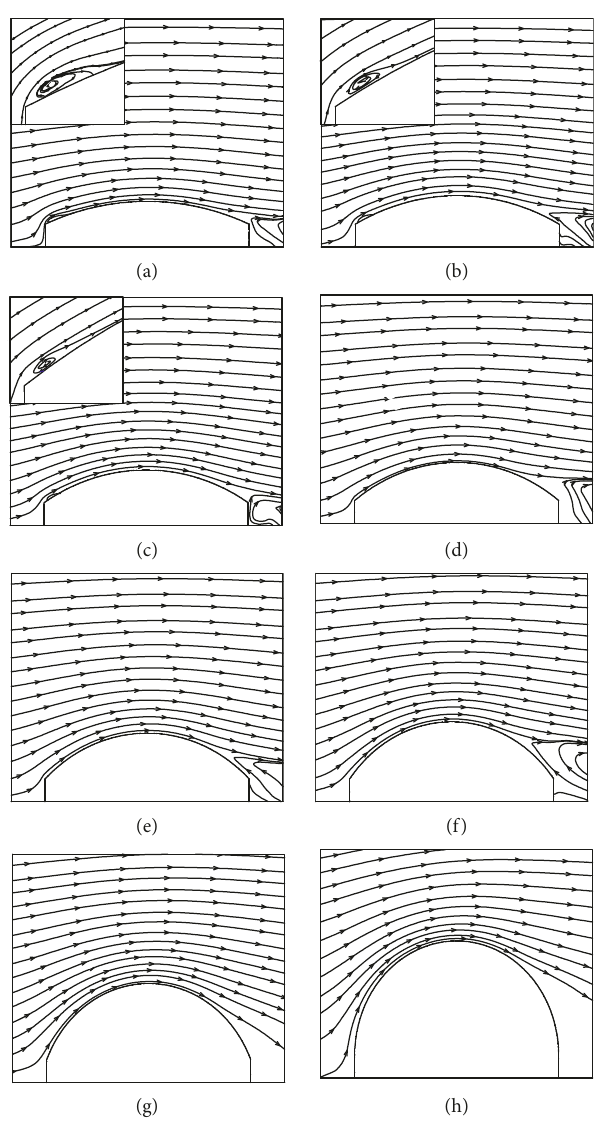
Figure 11: Streamline contours around the cylindrical roofs with different rise-to-span ratios. (a) R / S � 1/10. (b) R / S � 1/8. (c) R / S � 1/7. (d) R / S � 1/6. (e) R / S � 1/5. (f) R / S � 1/4. (g) R / S � 1/3. (h) R / S � 1/2.